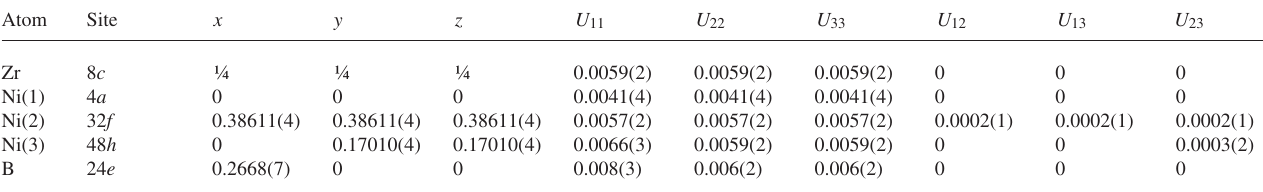
Table 4. Atomic coordinates and displacement parameters (in Å 2 ).